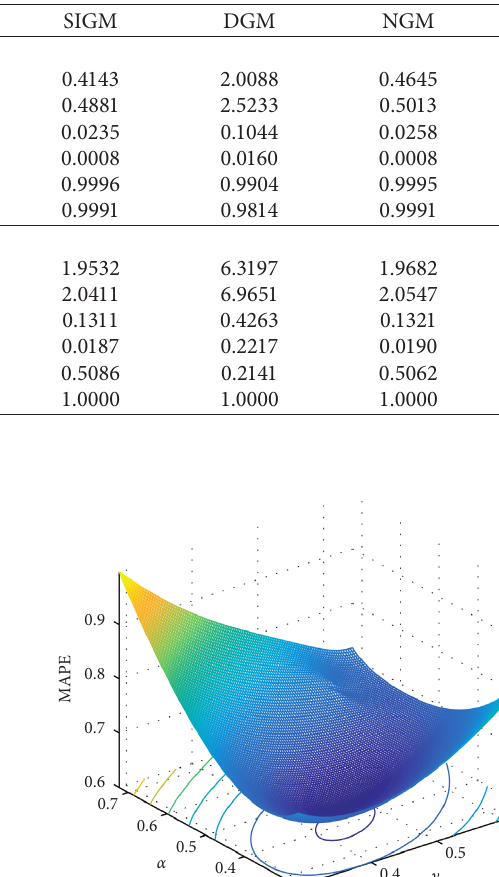
Table 5: Error metrics of energy consumption of urban civil buildings.